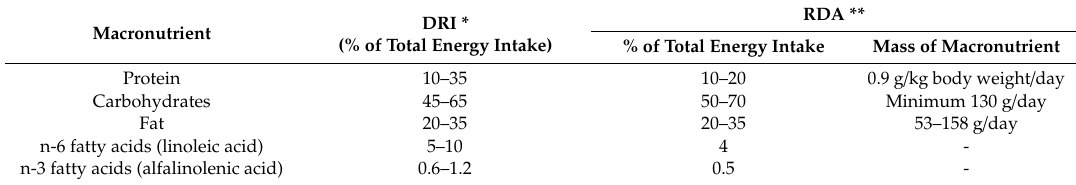
Table 1. References of macronutrient